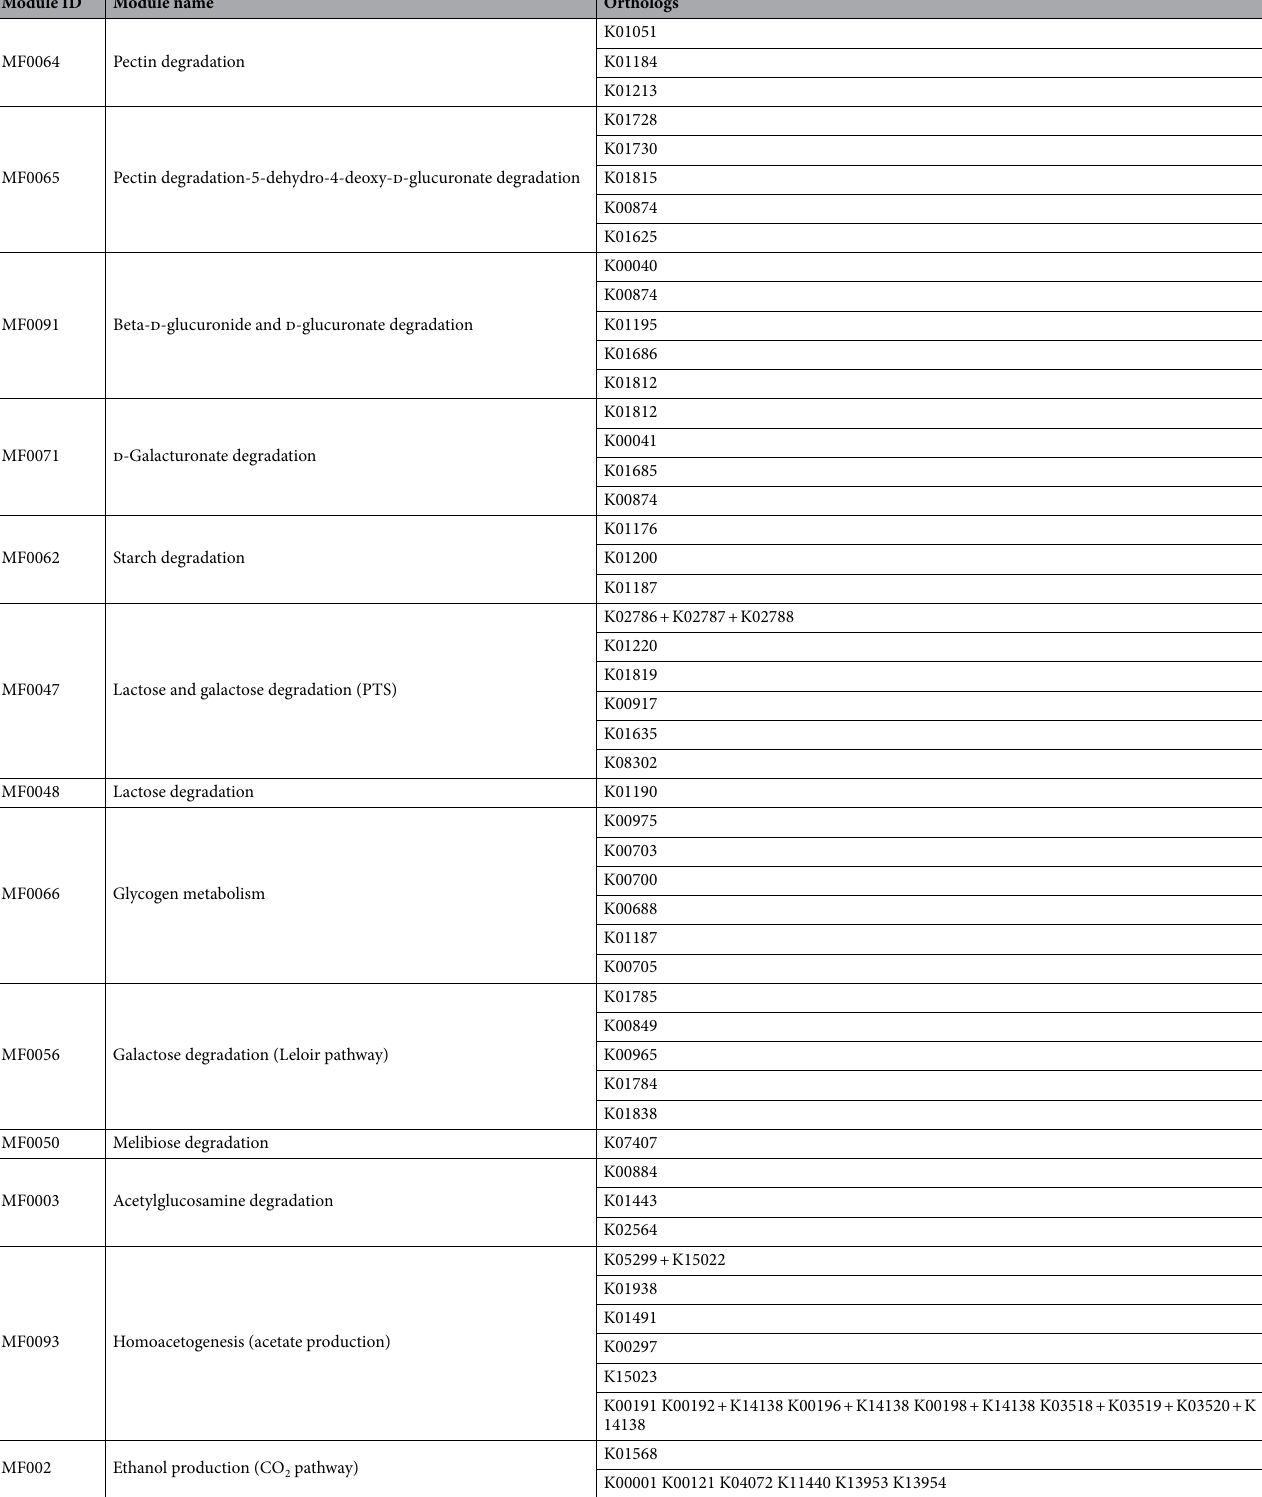
Table 1. Degradation pathways related to enzymes in the Prevotella CAZy-cluster. KEGG ortholog codes 23–25 were analyzed with GOMixer pathway analyzer. See text for